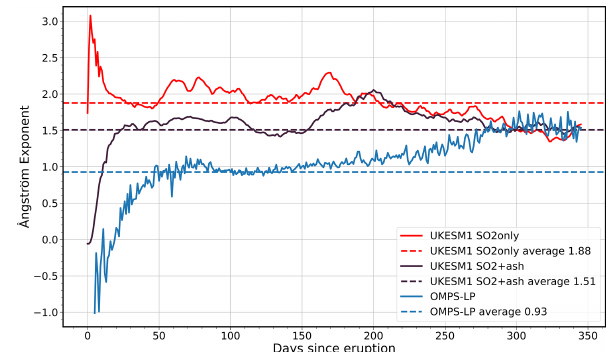
Figure 8. Daily evolution of the Ångström exponent for OMPS- LP (blue), UKESM1 SO2only (red), and UKESM1 SO2 + ash (dark purple) calculated using area-weighted sAOD between 30 and 90 ◦ N (same as Fig. 7) using 510 and 869nm